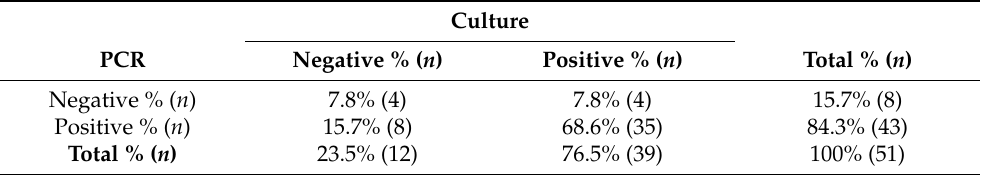
Table 2. Analysis of the relations between the results obtained by PCR and culture.